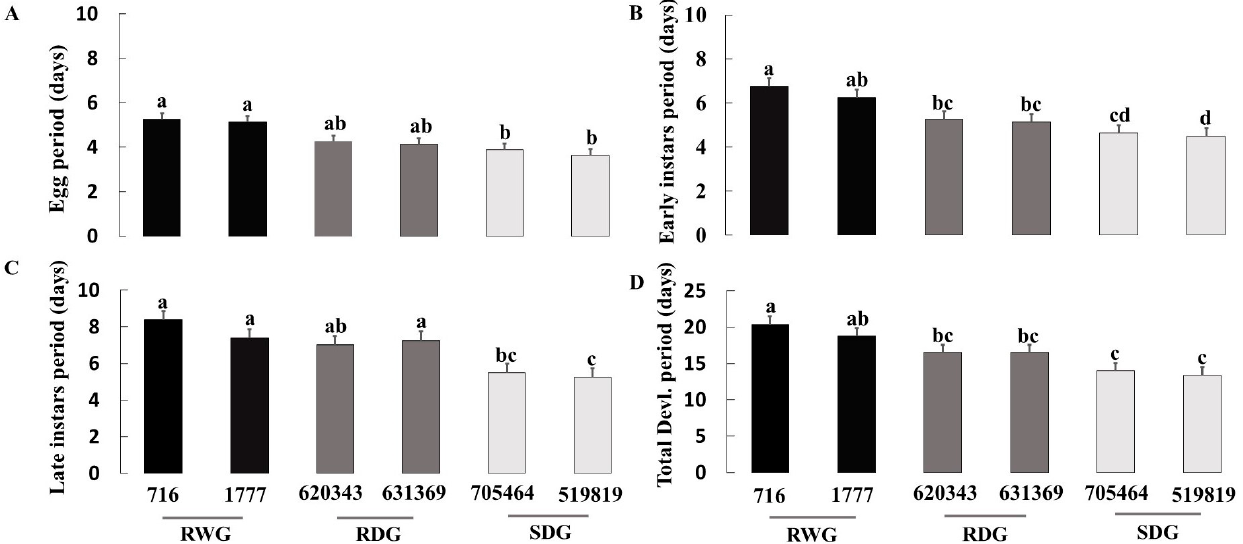
Figure 3. Mean (±SE) egg period ( A ), early instars period ( B ), late instars period ( C ), and total development period ( D ) of Orius laevigatus on six tomato genotypes of different levels of resistance to Phthorimaea absoluta . Bars with shared letters within the panel do not differ significantly (one-way ANOVA; Tukey’s test, p ≤ 0.05). RWG = resistant wild genotypes; RDG = resistant domesticated genotypes; and SDG = susceptible domesticated